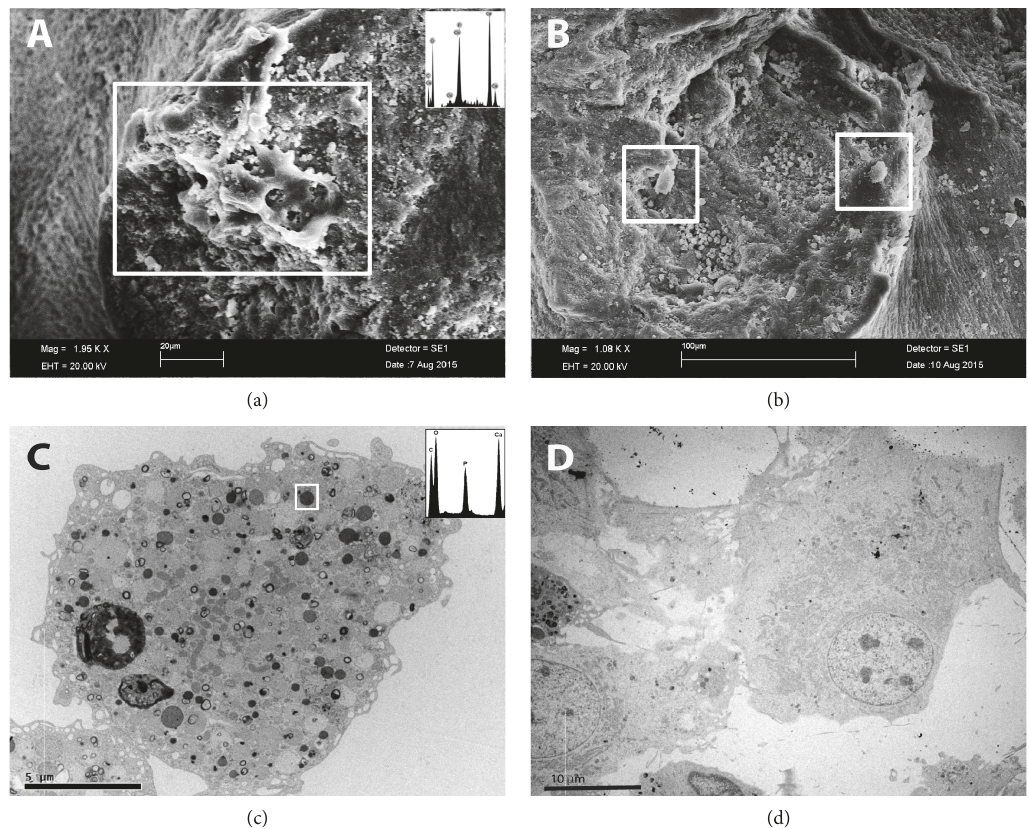
Figure 2: Electron microscopy demonstrating sca ff old colonization of BDSCs di ff erentiated with rapamycin, on bone sca ff old. (a) Higher magni fi cation of area indicated in the rectangle displays cells forming tissue-like agglomerates. Notably, electron micrograph captures an osteoblast matrix vesicle just as it initiated the exocytosis of hydroxyapatite (EDX spectrum). (b) Rectangles indicate di ff erentiated osteoblast-like cells as shown by transmission electron microscopy analysis. (c) Higher magni fi cation shows electron-dense granules within the mitochondria and the presence of calcium and phosphorus calcium phosphate aggregates typical of an osteoblast (EDX spectrum). (d) TEM image shows a typical osteoblast cell with fl at lamellipodia and dendritic fi lopodia (bar=20 μ m in (a), 100 μ m in (b), bar =5 μ m in (c), and 10 μ m in